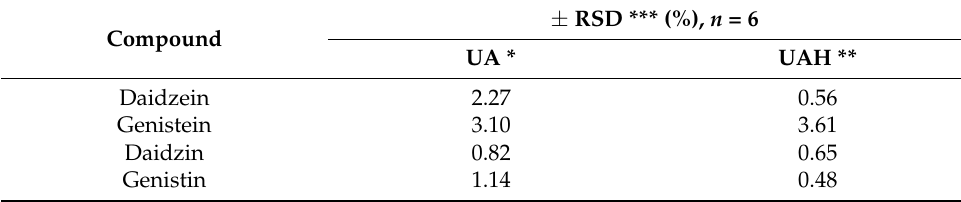
* Red clover sample sonicated for 10 min, at 40 ◦ C; ** red clover sample sonicated for 10 min, at 40 ◦ C and then heated under reflux for 1 h; *** recovery standard